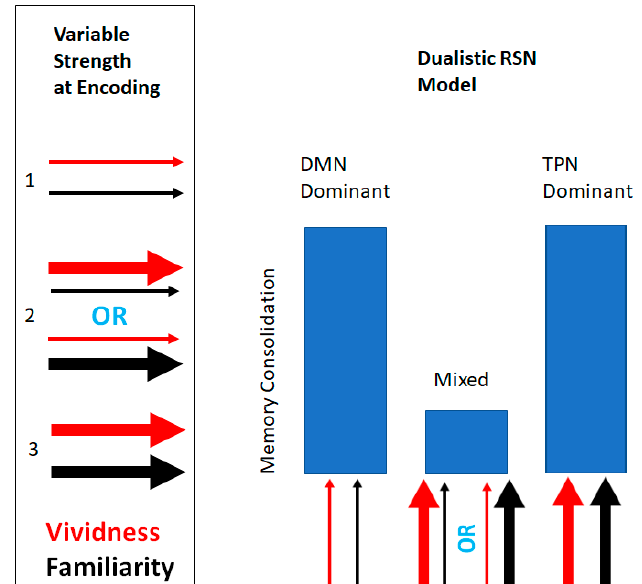
Figure 1. Schematic depicting the dualistic resting-state networks (RSN) neuropsychological model of memory consolidation. The model depicts its predicted memory consolidation score in relation to the three possible combinations of variable strength at the time of encoding. The width of the arrows indicates the strength of the variables at encoding.